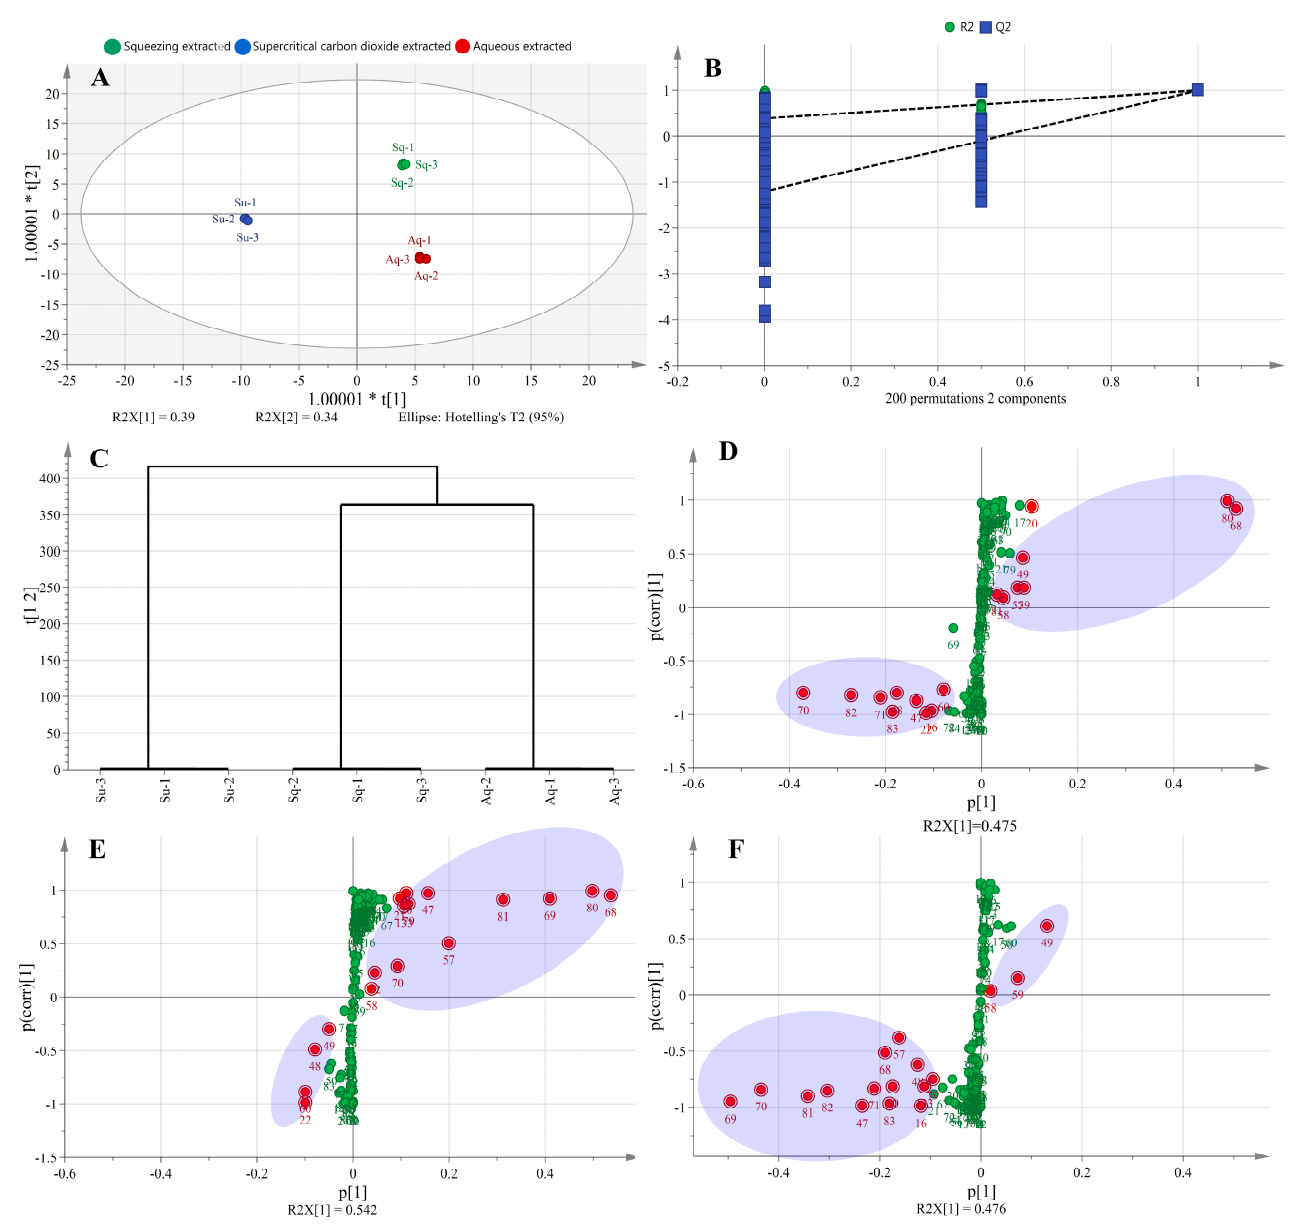
Figure 3. Scores plot of OPLS − DA model ( A ), cross − validation of OPLS − DA model ( B ), HCA ( C ), and S − plot of lipids with different extraction methods. Sq, Su, Aq in Figure 3(A) represent squeezing extraction, supercritical carbon dioxide extraction, and aqueous extraction, respectively. ( D ) Represents S − plot of squeezing extracted and aqueous extracted, ( E ) represents S − plot of supercritical carbon dioxide extracted and aqueous extracted, and ( F ) represents S − plot of supercritical carbon dioxide extracted and squeezing extracted. The red dots and green dots in Figure 3D–F indicate metabolites with VIP values > 1, and VIP values < 1, respectively.